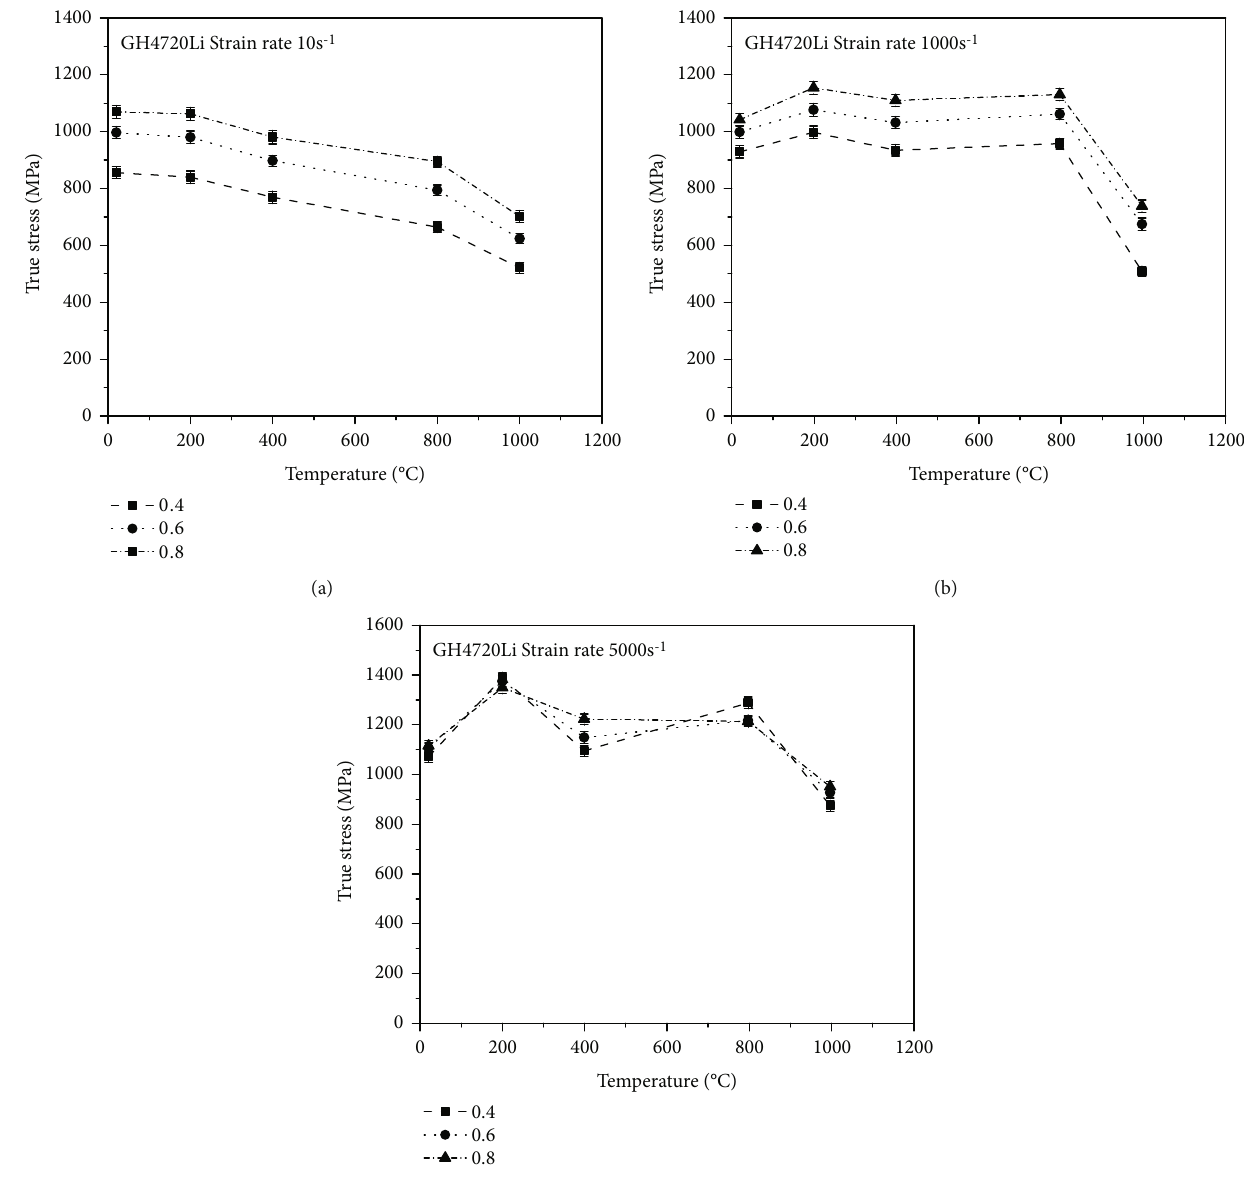
Figure 2: The fl ow stress VS. Temperature relations with strain rate of (a) 10/s, (b) 1000/s, and (c)